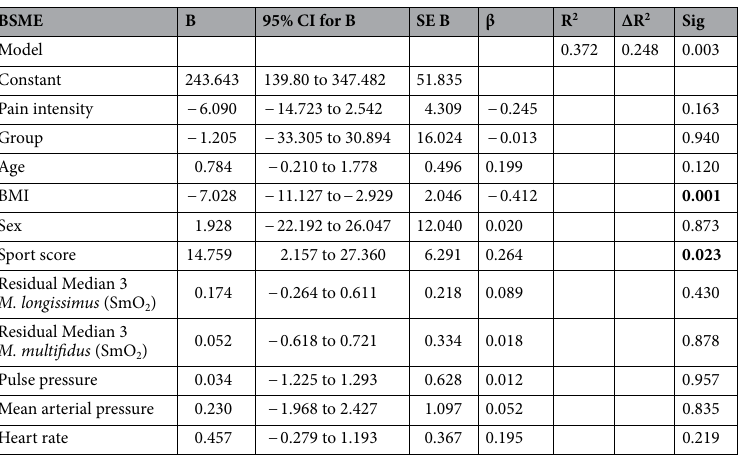
Table 5. Multiple regression results for BSME shown for Median 3. Displayed are B = unstandardized regression coefficient, CI = confidence interval, SE B = standard error of the coefficient, β = standardized coefficient, R 2 = coefficient of determination, ΔR 2 = adjusted R 2 and Sig. = significance. Significant values are in